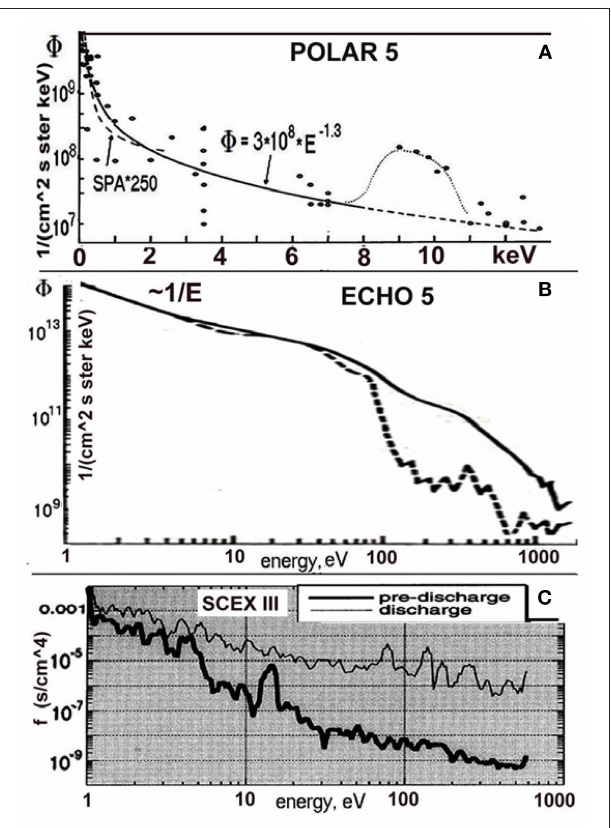
FIGURE 6 | (A) Suprathermal and beam electron spectra in Polar 5. The dashed line shows the SPA spectrum multiplied by 250. After Maehlum et al. (1980b) and Grandal (1982b). Suprathermal electron spectra in (B) Echo 5 with/without (the dashed/solid line) neutral gas injections, and (C) SCEX III. After Arnoldy et al. (1985) and Bale et al. (1995). Reprinted by permission from Elsevier, Plenum Press, and the American Geophysical